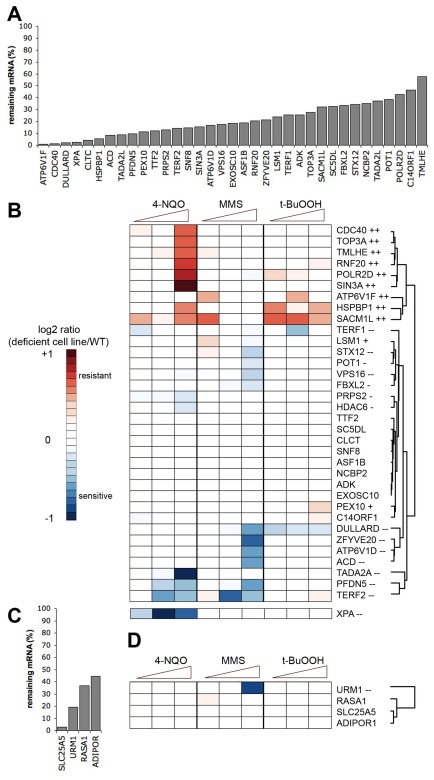
The majority of the selected proteins modulate the recovery after damage from the three compounds MMS, 4-NQO and t-BuOOH.A) RNA levels of shRNA targeted genes in 293T cells were measured by qRT-PCR and compared to cells infected with non-silencing control shRNA. B) Survival of cells depleted of target proteins exposed to three DNA damaging agents as revealed by heatmap. The color represents sensitivity to the damaging agent compared to the cell lines with non-silenced targets. ++ indicate high resistance. + low resistance, − high sensitivity, − low sensitivity. C) Knock-down of human homologs of non-toxicity modulating proteins in yeast, as measured by qRT-PCR. D) Survival of cells depleted of human homologs of non-toxicity modulating proteins in yeast. Colors and symbols are the same as in B.